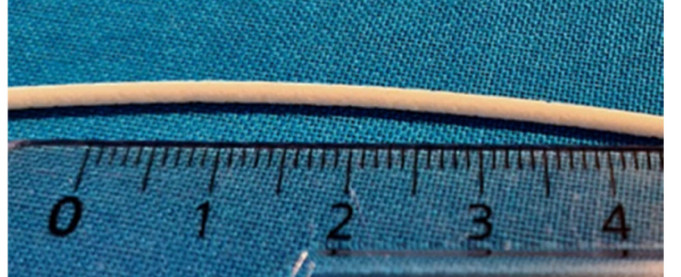
Figure 8. Picture of filament produced by HME (the five formulations have the same